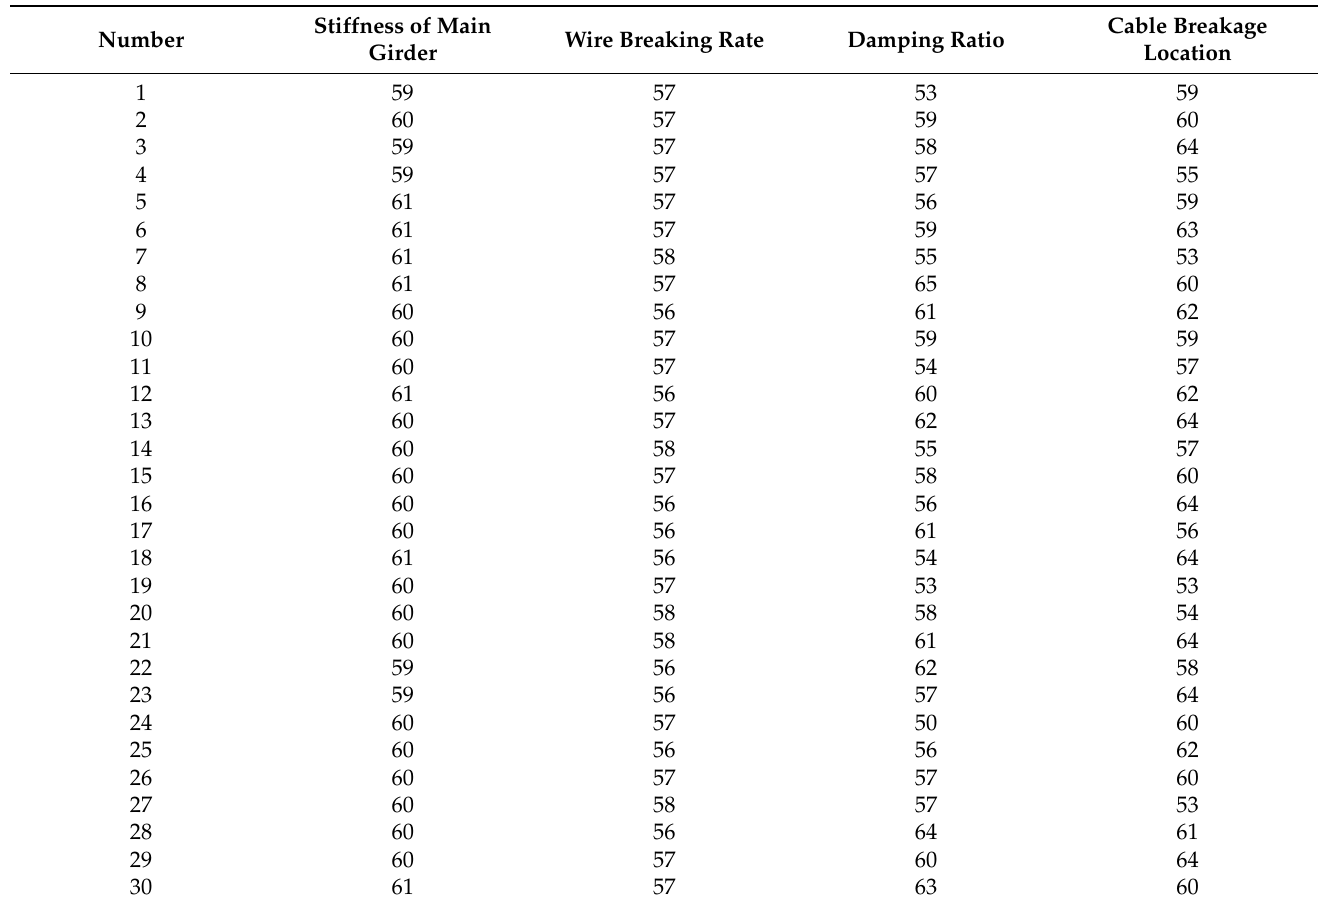
Table 8. Flutter critical wind speed, corresponding to 30 sampling results of different parame- ters (m/s).